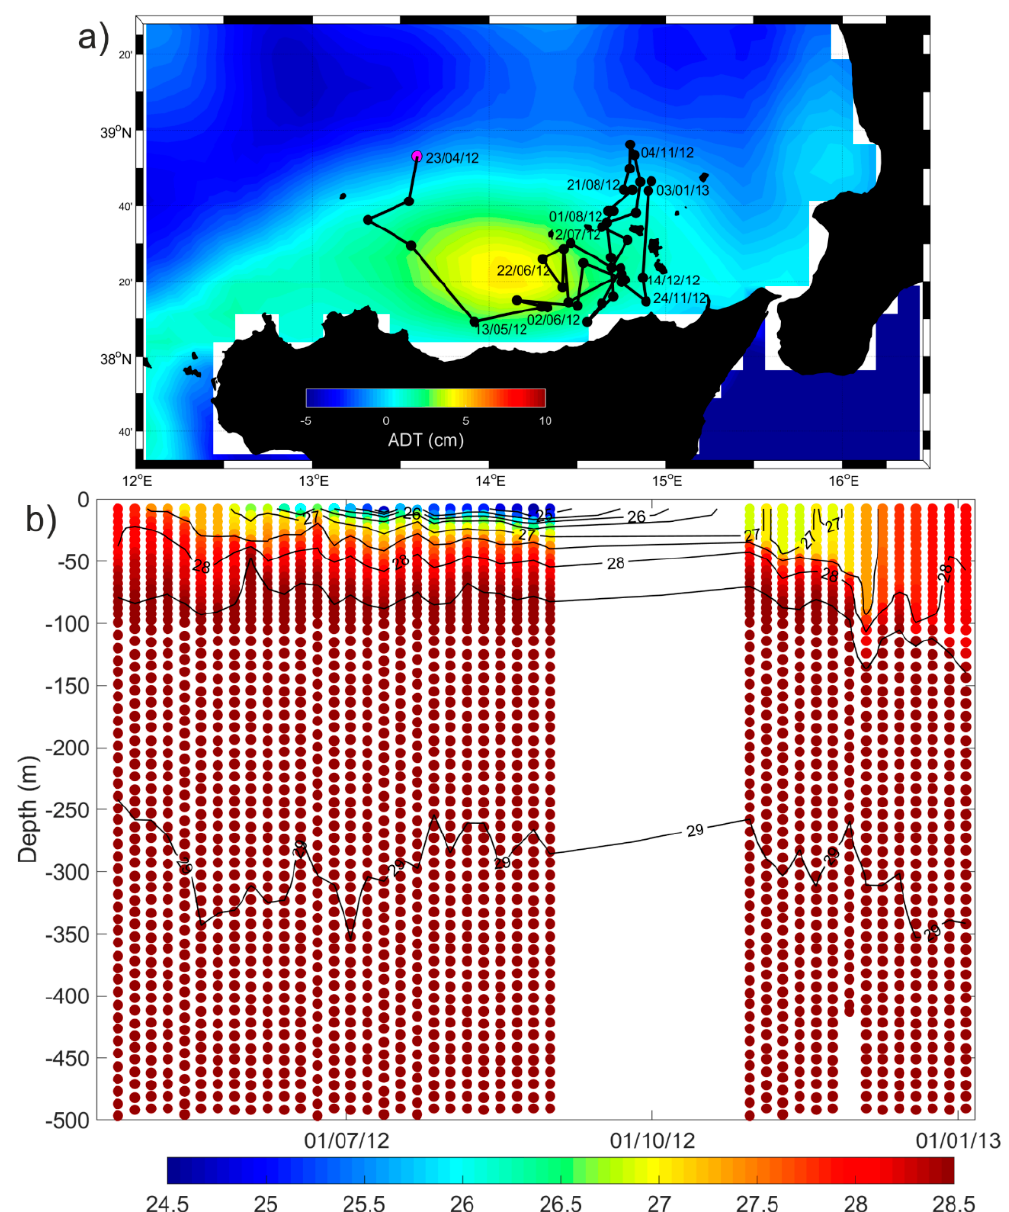
Figure 7. Map of the trajectory (black line) and profile positions (First profile: Magenta dot; Other profiles: Black dots) of the float WMO 6900981 superimposed on the mean map of the ADT (between 18 April 2012 and 3 January 2013) ( a ) and contour diagram of the potential density versus depth and time ( b ).